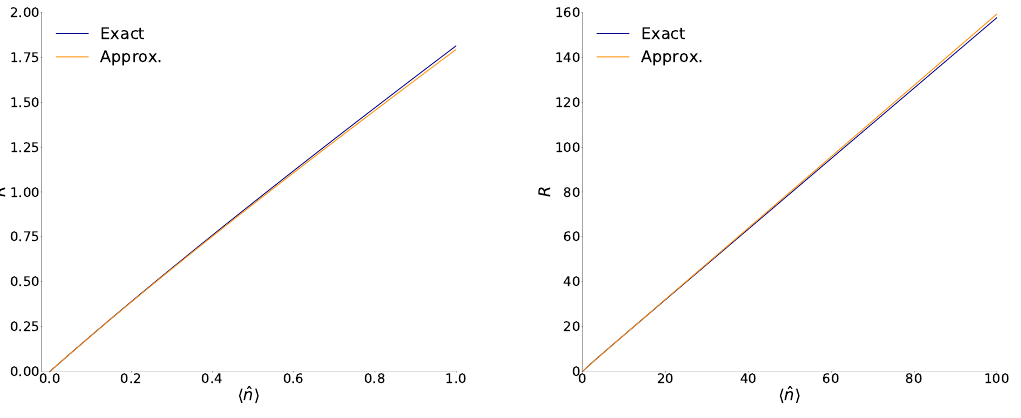
Figure 2. Parameter R versus the mean number of quanta (cid:104) ˆ n (cid:105) . Left: for (cid:104) ˆ n (cid:105) < 1. Right: for (cid:104) ˆ n (cid:105) < 100. The exact numeric calculations took into account 10,000 terms in formula